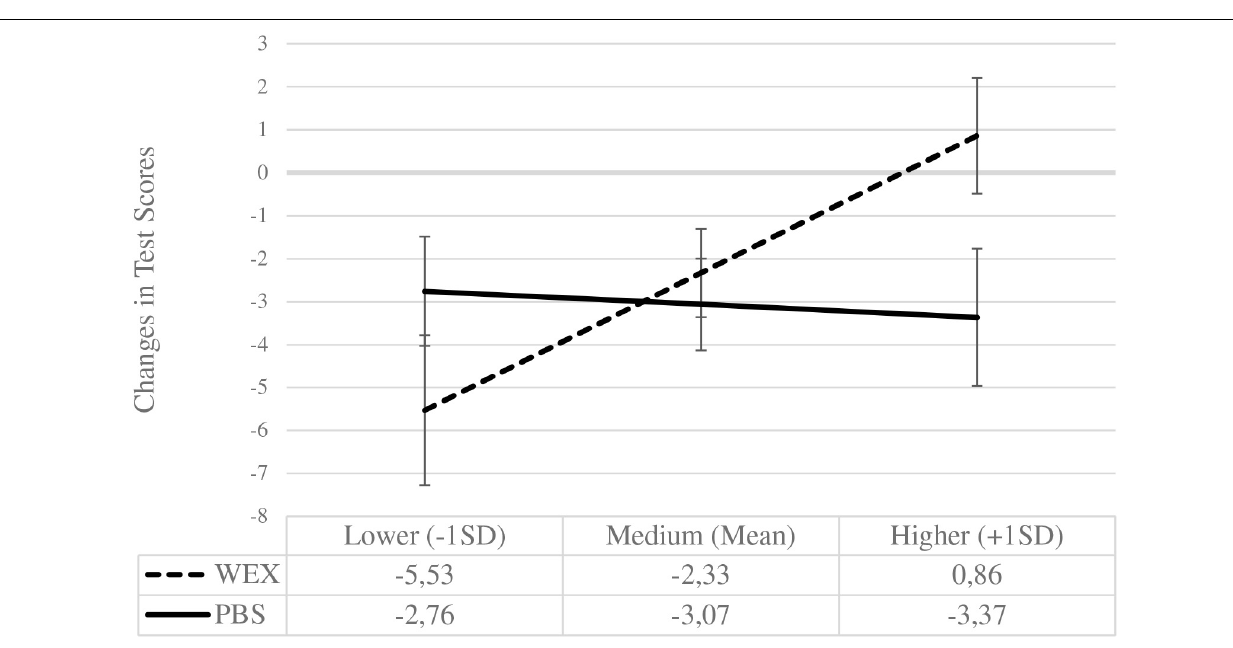
FIGURE 7 | Performance changes across both post-test by learning condition and initial performance expectancies. Change scores on the y -axis were computed by subtracting the delayed post-test scores from the immediate post-test scores: Zero means no change, negative values mean performance loss, and positive values mean performance gains. The x -axis anchors these changes for both learning conditions (WEX, worked-example (0), n = 32; PBS, problem-solving (1), n = 29) for lower, medium, and higher levels of performance expectancies. Error bars represent the standard error of the mean [WEX: 1.74 (–1SD), 1.03 (Mean), 1.35 (+1SD); PBS: 1.27 (–1SD), 1.07 (Mean), 1.60